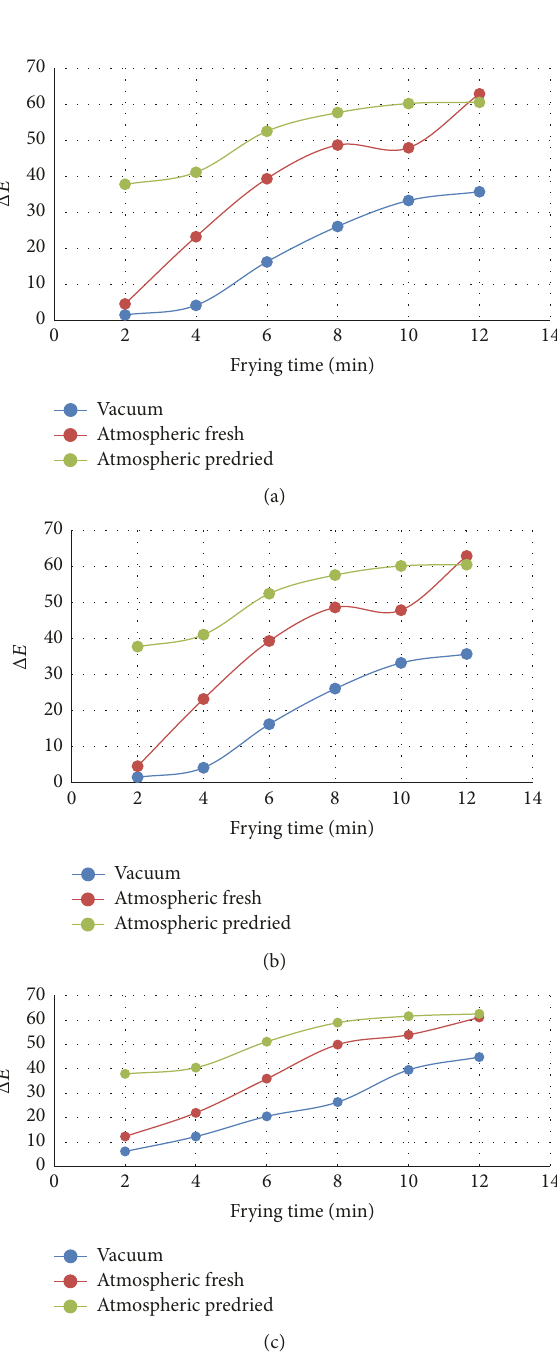
Figure5:Effectoffryingconditionsontotalcolourchangeinyellow fleshed cassava chips at different equivalent thermal driving forces (ETDF) of (a) 60 ∘ C, (b) 70 ∘ C, and (c) 80 ∘